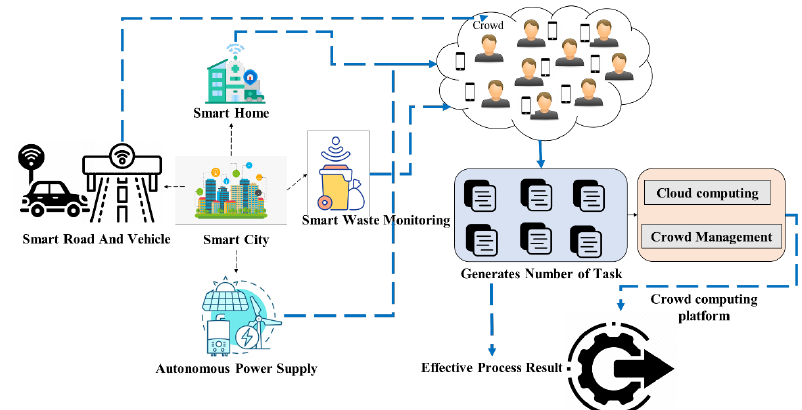
Figure 2. Crowd Computing with the Cloud for a smart city.